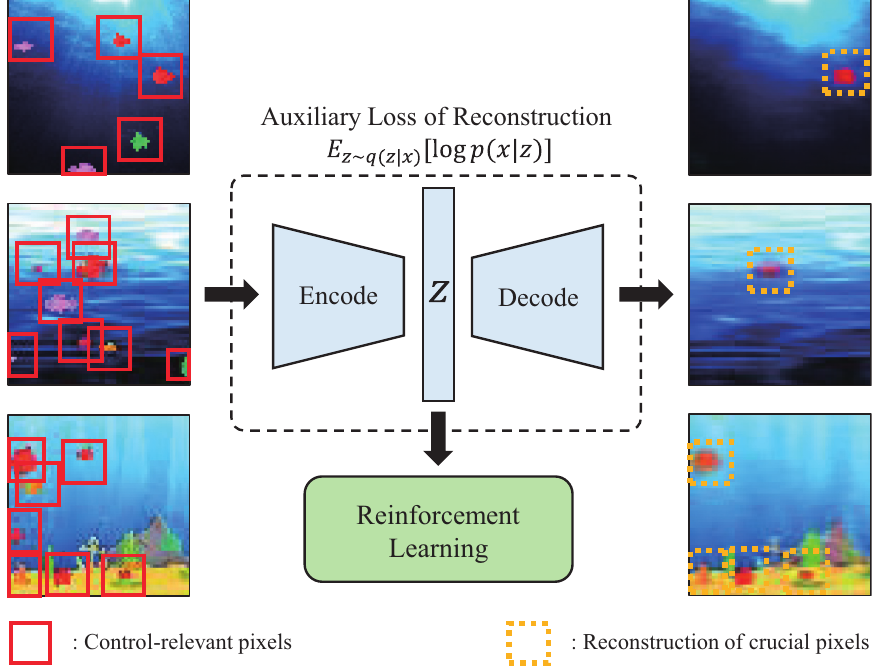
Fig 1. Reconstruction of auto-encoder based representation. This is the Bigfish of ProcGen environment, which has various wallpaper patterns in the background. Under the auxiliary task of reconstructing original inputs, left images are pixel-inputs and right are reconstructions of their representations. It shows a problem that if there are various control-irrelevant details in wallpaper pixels, the encoder first learns abstraction about irrelevant details for gameplay instead of the essential pixels (i.e., fish in this example). Our proposal was motivated by this